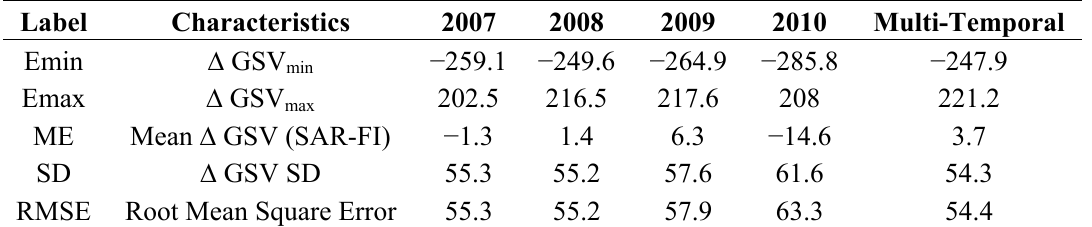
Table 4. Validation results, overall statistics of SAR and forest inventory (FI)-based GSV comparison (m 3